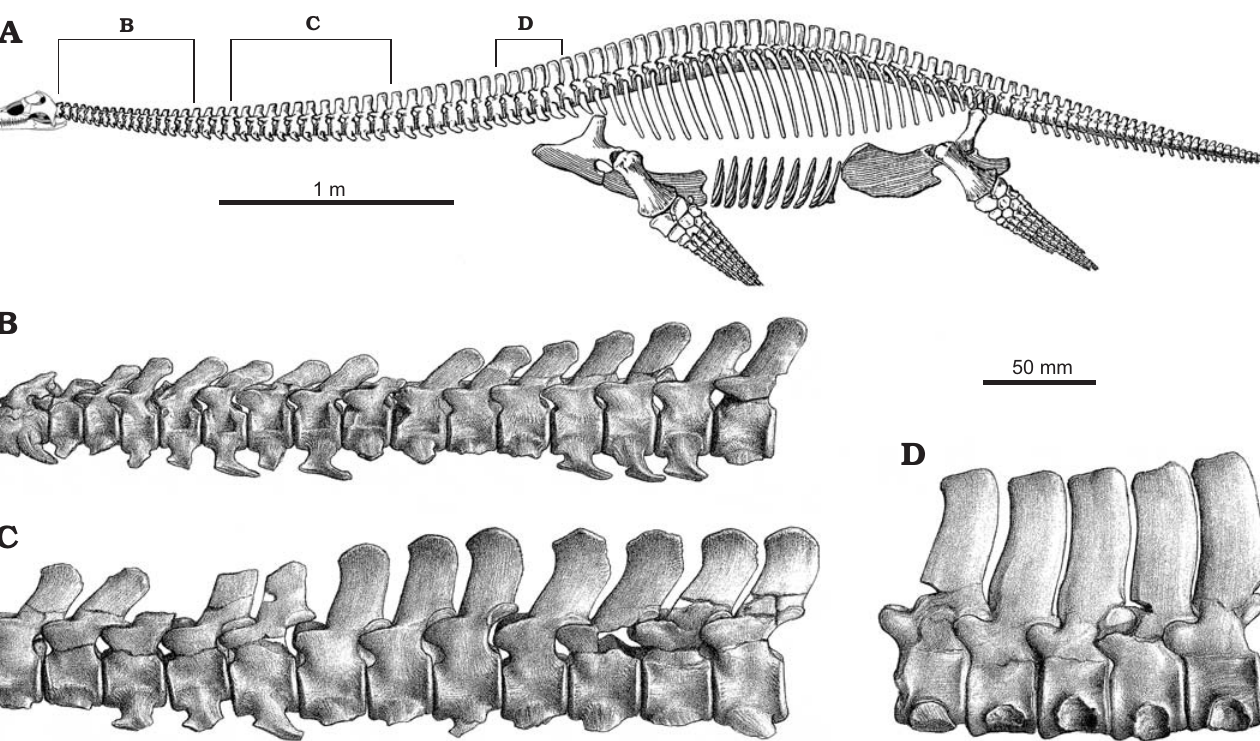
Fig. 8. Skeletal reconstruction of Muraenosaurus and articulated vertebrae of Muraenosaurus beloclis in right lateral view. A . Skeleton showing the ap- proximate locations of the vertebral series (B–D). B . Articulated atlas-axis complex and C3–C17. C . Articulated series of 12 mid-cervical vertebrae. D . Posterior cervical vertebrae. B–D reversed to match skeleton above. Images from: A, Andrews (1910: fig. 66) with the newly reconstructed head based on Evans (1999); B–D, Andrews (1910: pl. 7: 5,